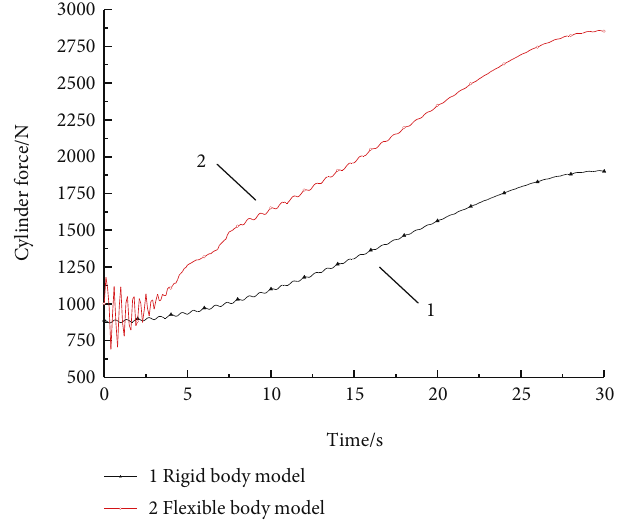
Figure 6: Hydraulic cylinder force comparison between the two